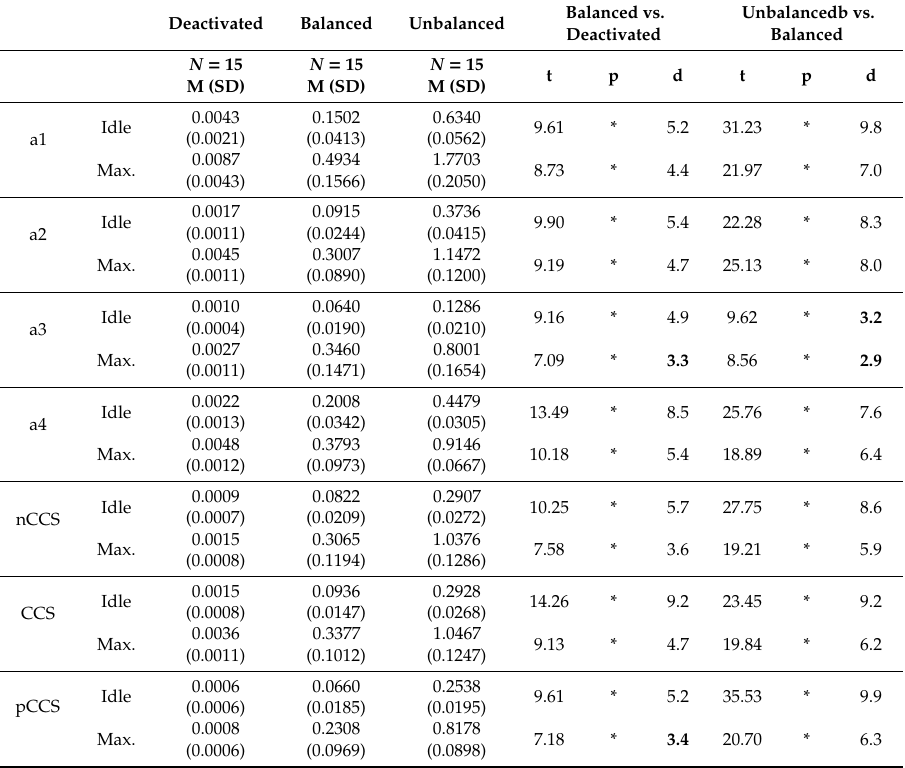
Table 3. Sample description and statistical comparison of the peak amplitudes of the thresher, detected in individual spectra (a1–4), and the non-coherent (nCCS), coherent (CCS), and poly-coherent (pCCS) composite spectra, under di ff erent working conditions (deactivated, balanced and non-balanced) and at di ff erent speeds (at idle and at max. RPM). Balanced vs. Unbalancedb vs. Deactivated Balanced Unbalanced Deactivated Balanced N = 15 M